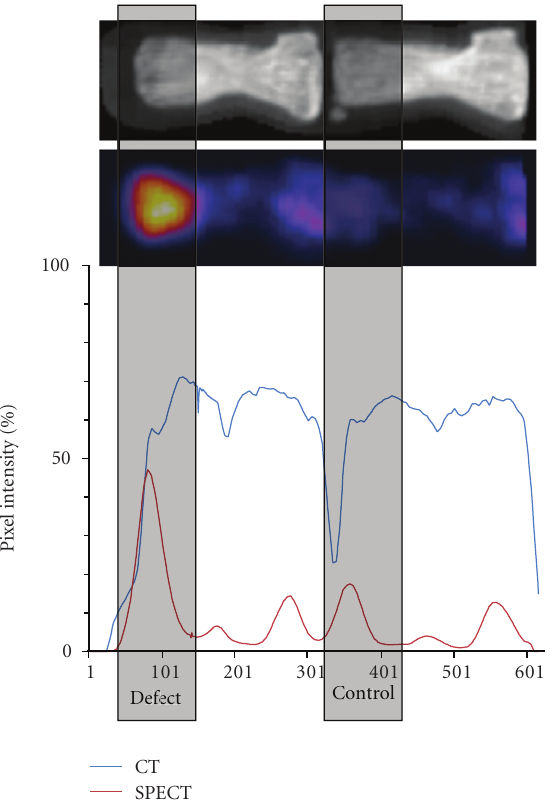
Figure 4: Comparison of intensities from CT (blue line) and nano- SPECT (red line) images. A representative image shows that the peak intensity of a vertebral epiphysis can be localized on the basis of the CT image and compared to the defect site. SPECT intensities reflect osteoblast activity. The defect site has a significantly higher osteoblast activity than the normal bone.